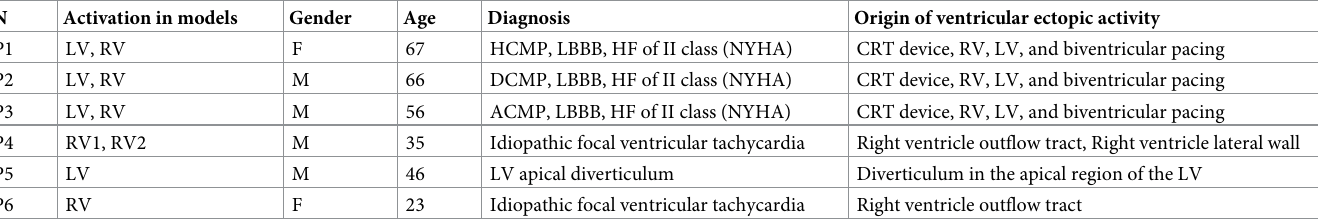
Abbreviations: hypertrophic cardiomyopathy (HCMP), left ventricular bundle branch block (LBBB), heart failure (HF), New York Heart Association (NYHA) class, arrhythmogenic cardiomyopathy (ACMP), and cardiac resynchronization therapy